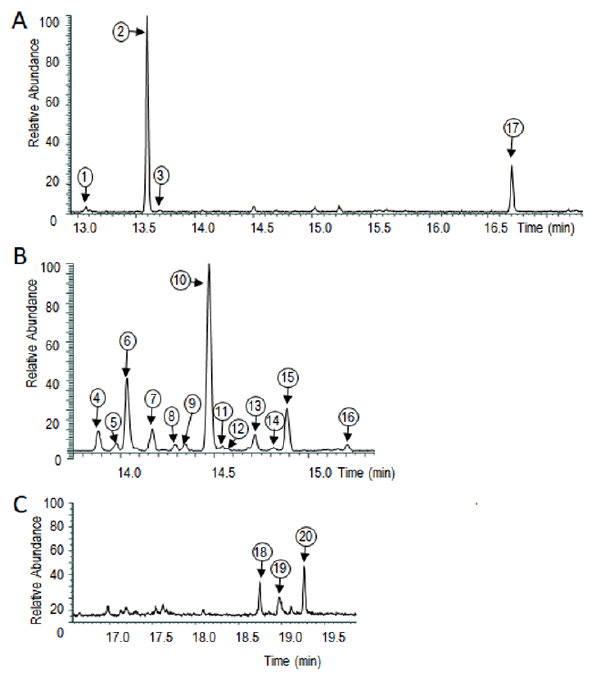
Figure 2. Sesquiterpenes formed by axenic T. vaccinum. ( A ) The major peaks are visible with the entire spectrum. ( B ) Enlarged view allows us to differentiate peaks number 4 through 16. ( C ) Enlarged view of the peaks eluting at higher retention times, numbers 18 through 20. The peaks were numbered consecutively; for each peak a number is given in a small circle above the peak to identify the compound for further analyses. The retention times of the 20 peaks were used for identification with authentic standards, and by mass spectrometry (see Supplementary Table S1). The peak numbers ( 2 ) ( ∆ 6 -protoilludene), ( 3 ) (sativene), ( 4 ) (isocaryophyllene), ( 5 ) ( β -cedrene), ( 6 ) ( α -barbatene), ( 7 ) ( β -copaene), ( 8 ) (thujopsene), ( 10 ) ( β -barbatene), ( 13 ) (4-epi- α -acoradiene), ( 15 ) (chamigrene), and ( 16 ) ( α -cupraene) could be identified, while peaks ( 1 ), ( 9 ), ( 11 ), ( 12 ), ( 14 ) and ( 17 )–( 20 ) did not